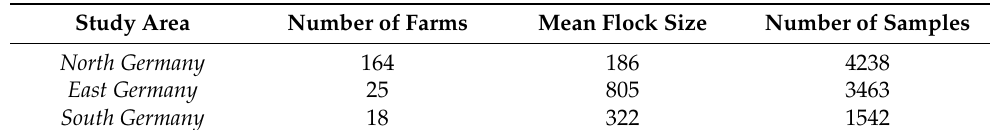
Table 1. Number of farms, mean flock size and number of swab samples collected in the three study areas.